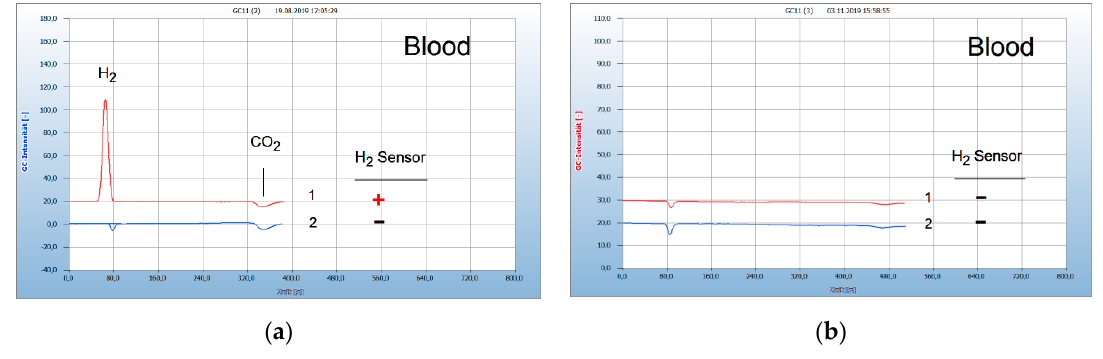
Figure 1. Analysis of blood after garlic therapy by in vivo test. Gas chromatography: column Analysis of blood after garlic therapy by in vivo test. Gas Chromosorb 102, carrier gas ambient air, 6 mL headspace vials, 2.5 mL culture broth, blank: cotton bud in culture broth, H 2 emission ( + ), no H 2 emission ( − ). ( a ) 1 = blood after insufficient doxycyclin theray ( + ), 2 = blank: ( − ). ( b ): 1 = blood after 4 weeks garlic therapy ( − ), 2 = blank: ( − ).